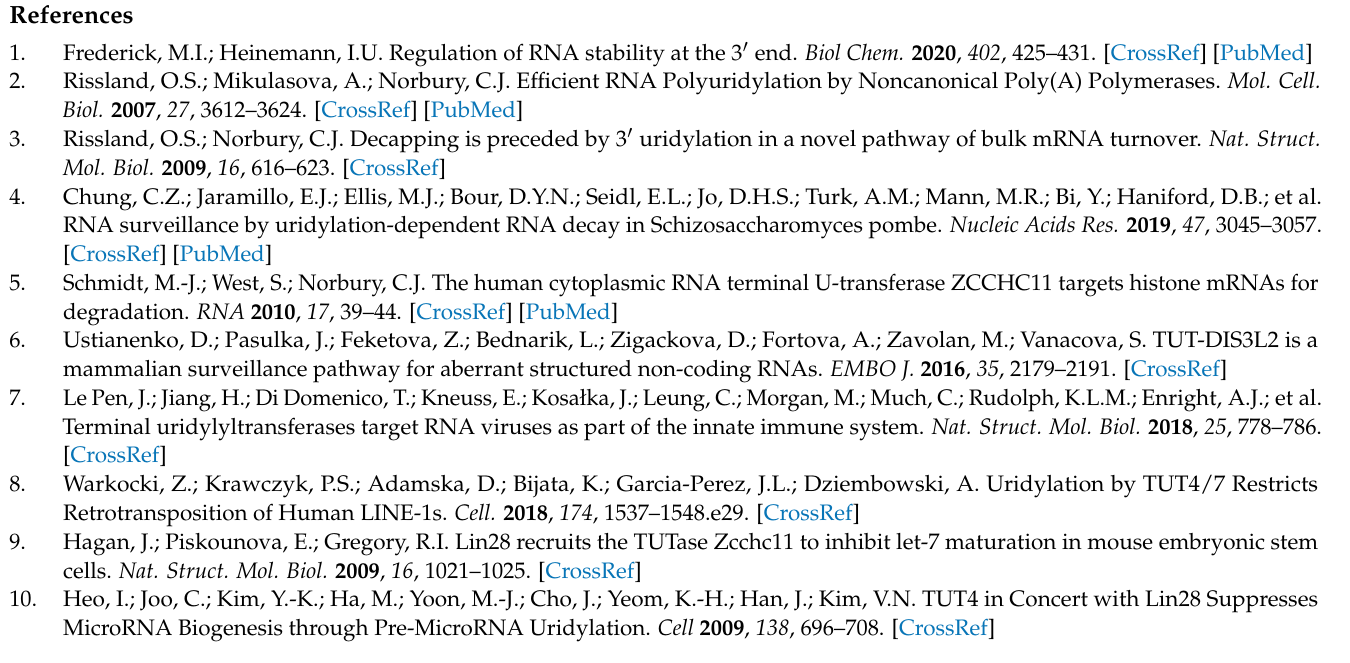
S14. Table S1: Oligonucleotides used in this study; Table S2: miRNAs significantly increased in abundance > 2-fold in ∆ TUT4/7; Table S3: miRNAs significantly decreased in abundance > 2- fold in ∆ TUT4/7; Table S4: Differentially expressed miRNA genes ( ≥ 2-fold) raw counts; Table S5: miRNA families increased in abundance in ∆ TUT4/7 cells. Individual miRNA family members are significantly increased by at least 2-fold; Table S6: miRNA families decreased in abundance in ∆ TUT4/7 cells. Individual miRNA family members are significantly increased by at least 2-fold; Table S7: Group II miRNA decreased or increased by at least 2-fold in abundance, or unchanged in ∆ TUT4/7 cells compared to WT cells; Table S8: Gene Ontology (GO)—biological process analysis of mRNAs increased in abundance in ∆ TUT4/7 cells; Table S9: Gene Ontology (GO)—biological process analysis of mRNAs decreased in abundance in ∆ TUT4/7 cells; Table S10: Target mapping in the miRNA/mRNA network. DE = significantly differentially expressed by at least 2-fold. Parentheses indicate number of target genes out of total number of target genes that are decreased in abundance in ∆ TUT4/7 cells. Shared targets include mRNA targeted by multiple let-7 family